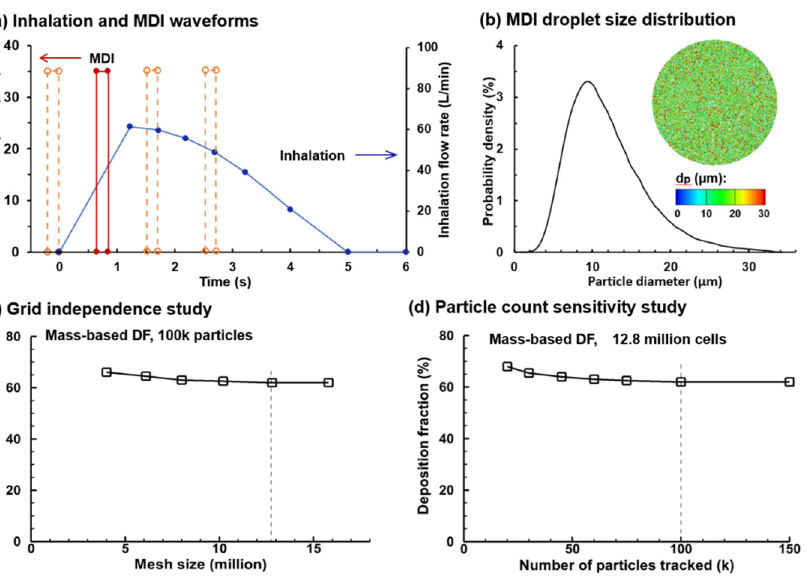
Figure 3. MDI delivery parameters and sensitivity studies: ( a ) deep slow inhalation and MDI administration waveforms; ( b ) MDI droplet size distribution, with a mean diameter of 11.0 µm and a geometric standard deviation of 1.57; ( c ) grid independence study with the mesh size ranging 4–16 million; and ( d ) droplet count sensitivity study with the number of sample droplet ranging 20–150 k. To study the effect of the MDI actuation timing on drug delivery, the MDI was applied at three more points within the inhalation cycle (i.e., 0.0, 1.5, and 2.5 s after inhalation onset) were considered in addition to the baseline case (i.e., 0.63 s after inhalation onset, red solid line).